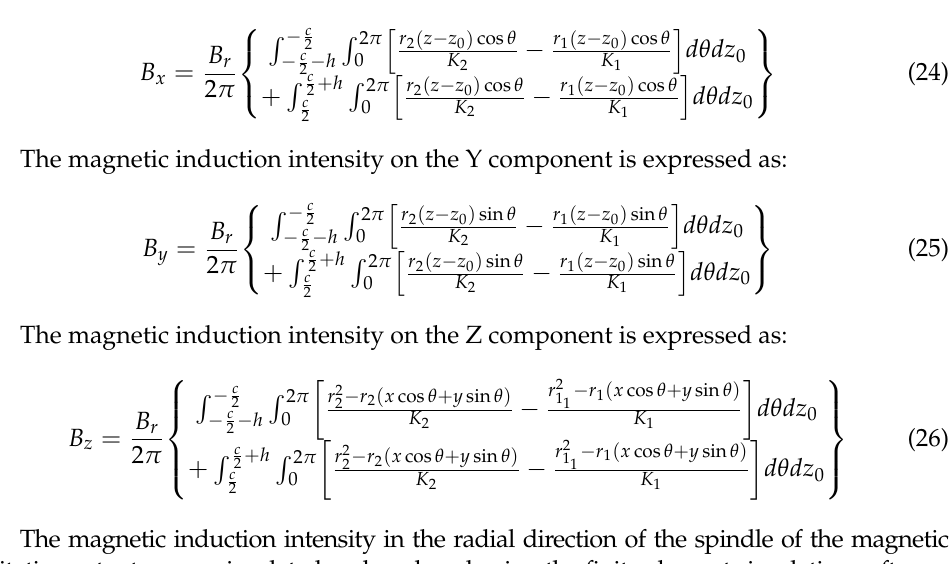
Figure 6. Magnetic array magnetic field model. Similarly, according to the superposition principle of the magnetic field, the magnetic induction intensity on the X component of P ( x , y , z ) can be expressed